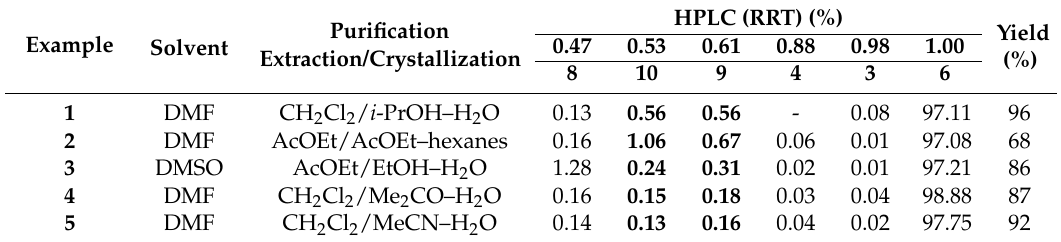
Table 1. Synthesis and HPLC data of N -tritylolmesartan medoxomil ( 6 ) samples.